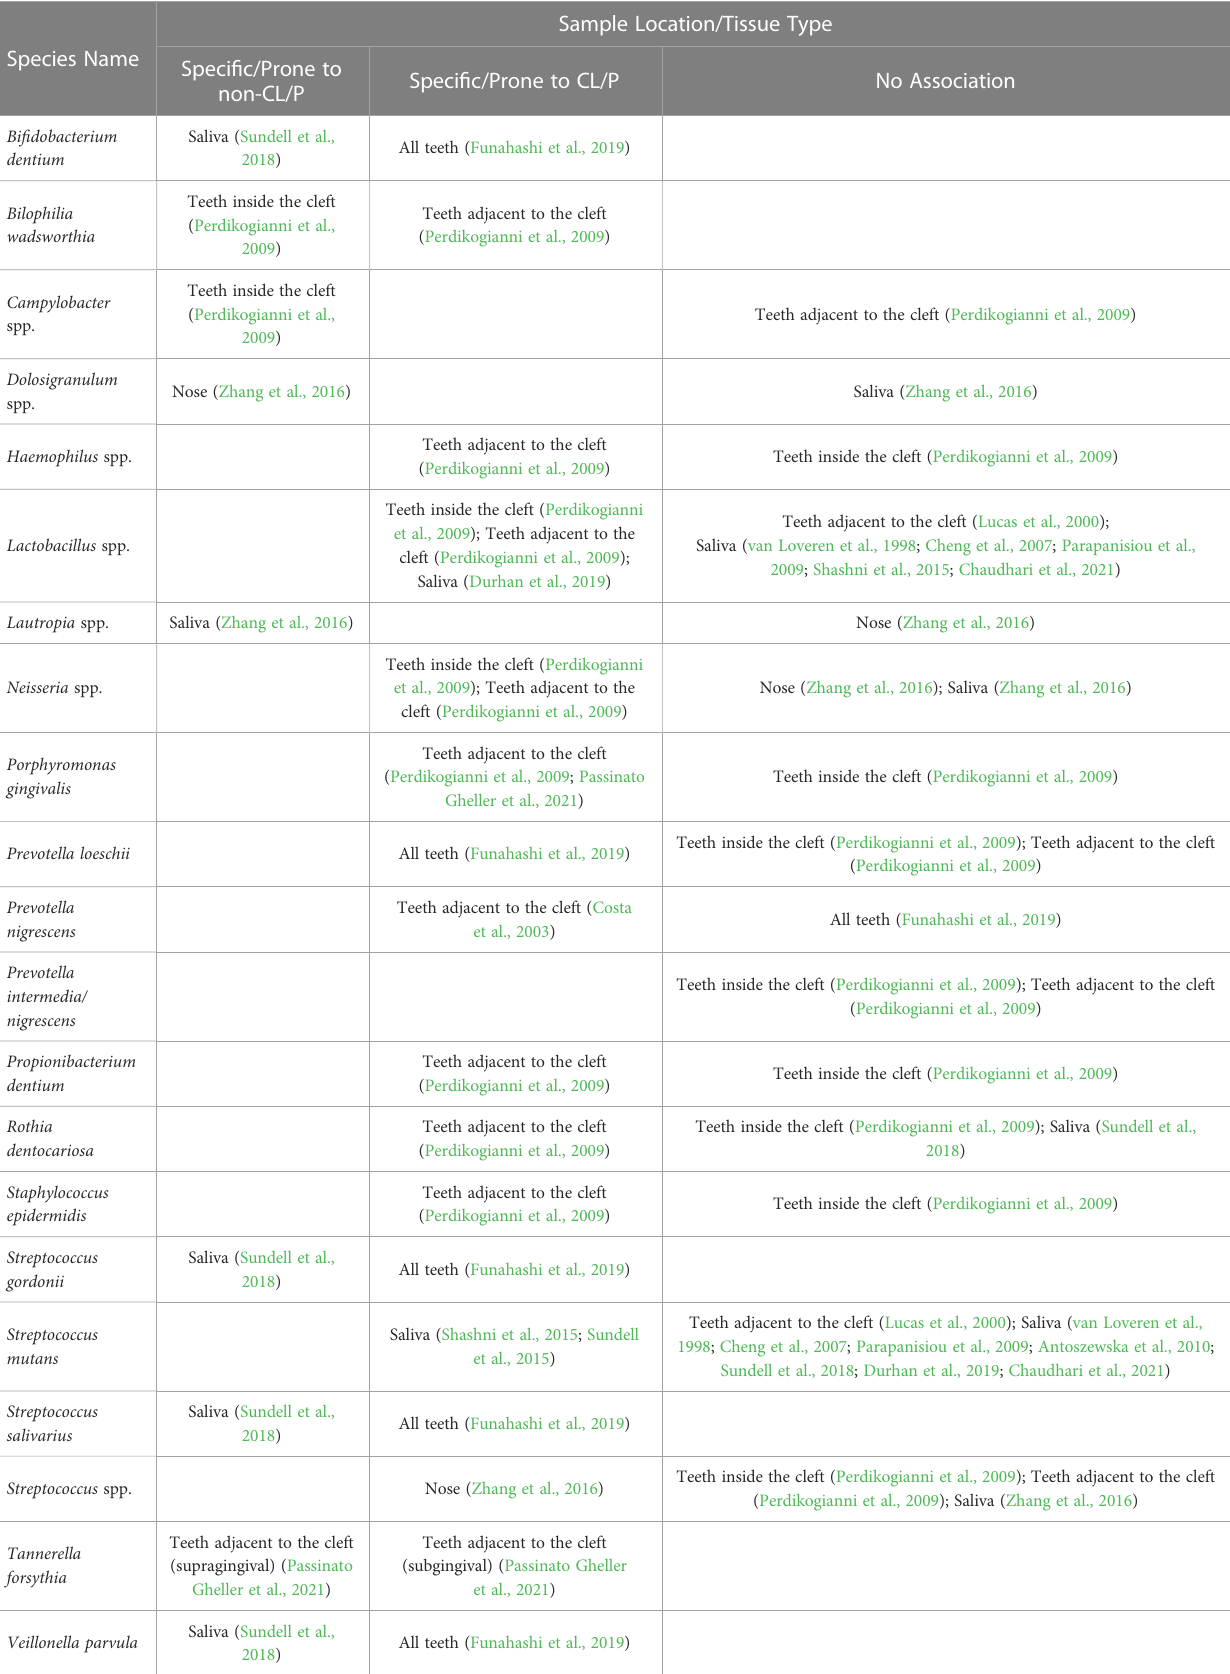
TABLE 4 Con fl icting data on bacterial species ’ association with CL/P in different